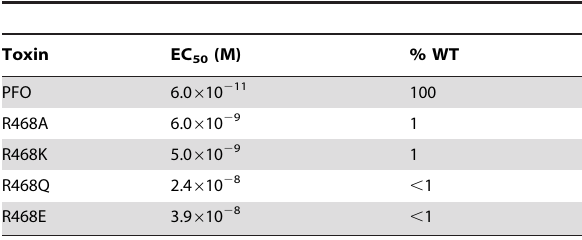
Table 1. Cytolytic activity of PFO derivatives with mutations in the Arg-468